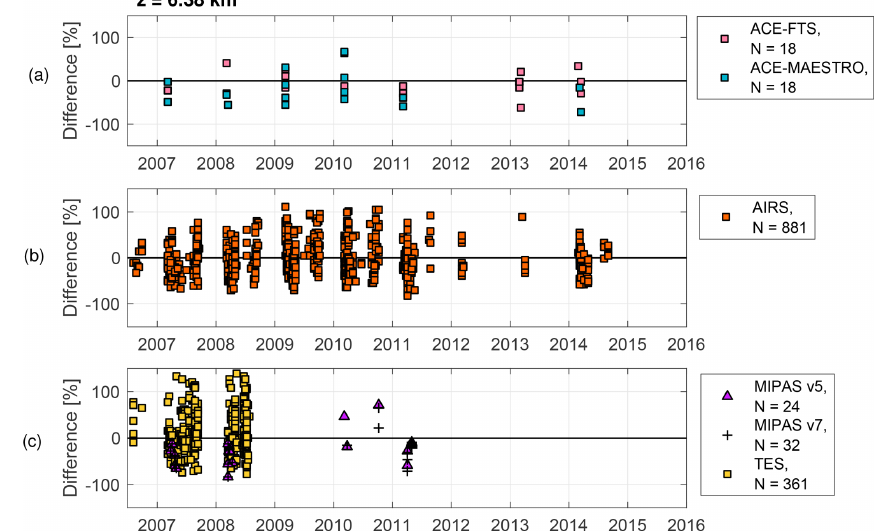
Figure 7. Time series of percent differences between satellite and 125HR water vapour measurements at 6.4km altitude for (a) ACE-FTS and ACE-MAESTRO, (b) AIRS, and (c) MIPAS and TES. In each case, the differences follow Eq. (3), where the satellite is X and the PEARL 125HR is Y